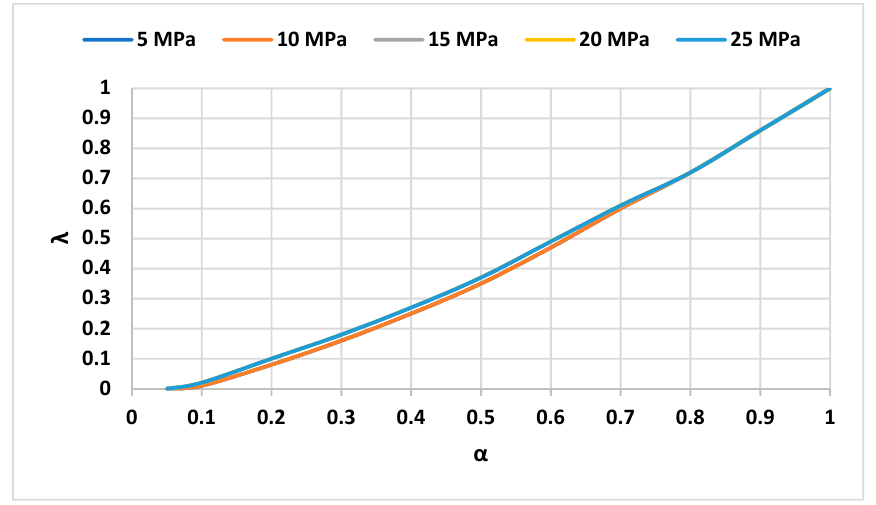
Figure 7. Changes of λ about α for different operating pressures.